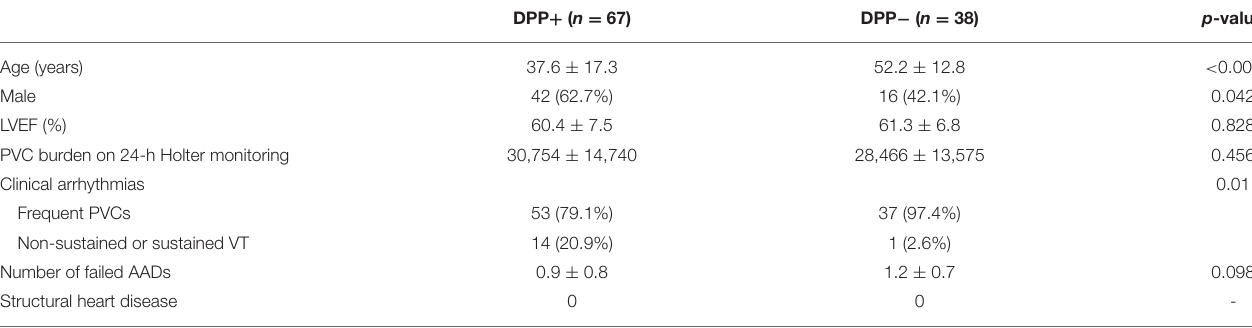
TABLE 1 | Baseline clinical characteristics in patients with and without DPP.